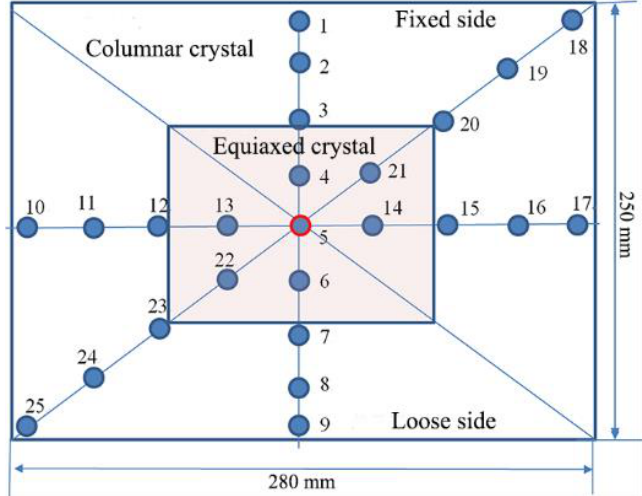
Figure 9. Schematic diagram of sampling location for C segregation measurement.